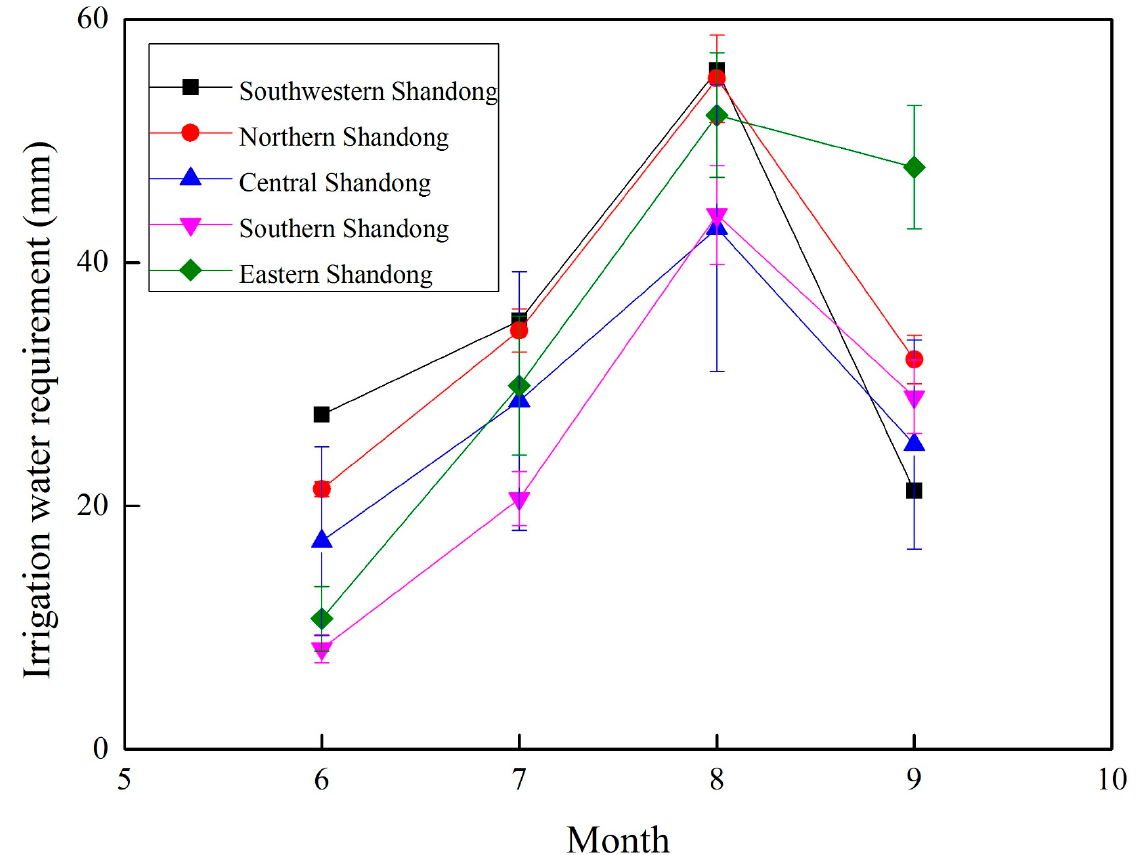
Figure 4. Irrigation water requirements in the summer maize growth period. Note: The error bars are standard deviations, and the values are monthly averages.